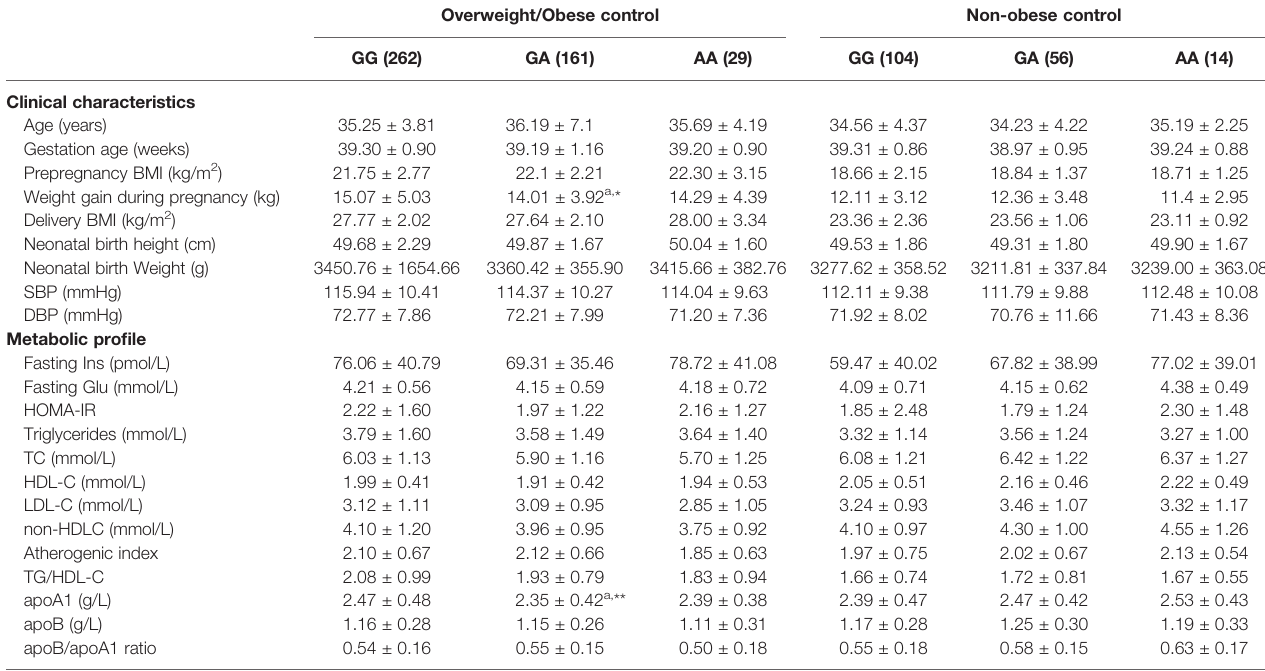
TABLE 5 | Clinical characteristics and metabolic pro fi le of GALNT2 rs4846914 genotypes in overweight/obese and non-obese control subjects.